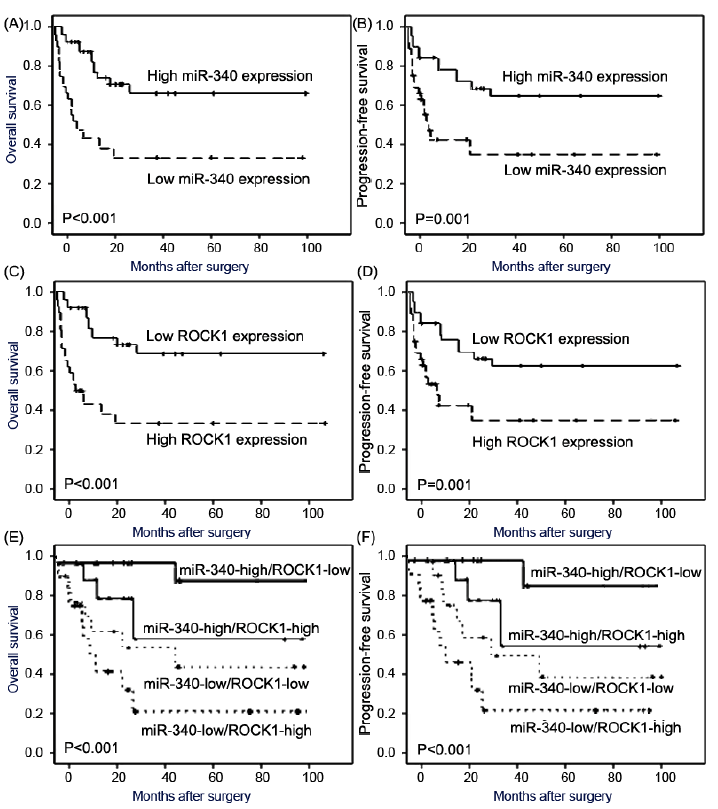
Figure 4. Kaplan-Meier survival curves for osteosarcoma patients with high and low expression of miR-340 [( A ) for overall survival, ( B ) for progression-free survival], ROCK1 mRAN [( C ) for overall survival, ( D ) for progression-free survival], and concomitant miR-340 and ROCK1 [miR-340/ROCK1, ( E ) for overall survival, ( F ) for progression-free survival].